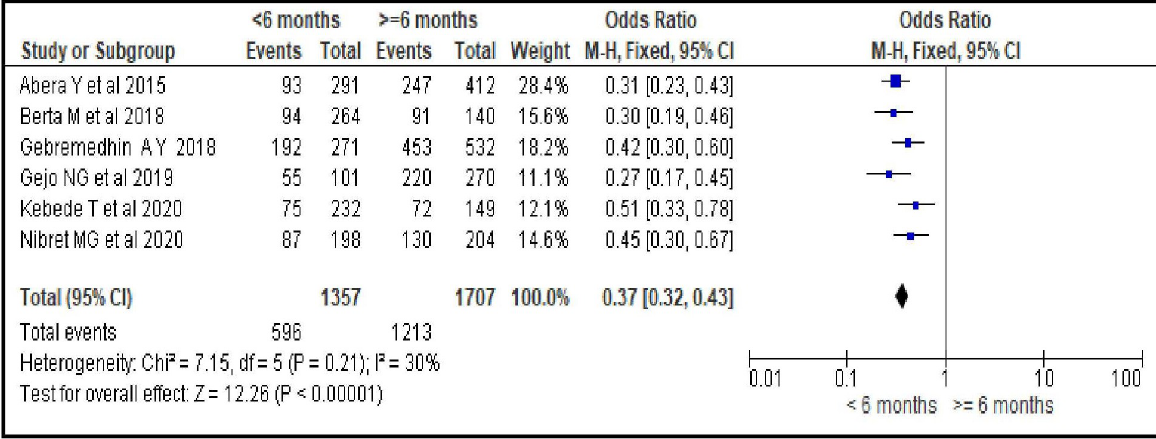
Fig 12. Association between length of time after last delivery and modern contraceptive uptake during postpartum period,